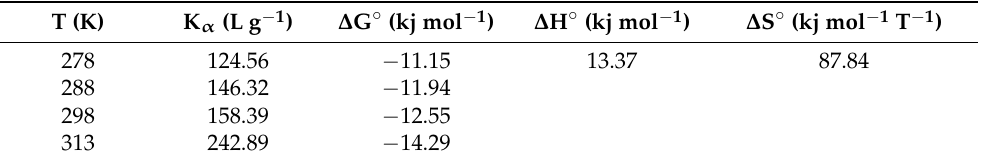
Figure 8. ( A ) Dependence of MB adsorption on temperature and ( B ) Vant’ Hoff plot of the MB adsorption onto Lipo- some@PDA microspheres. Table 4. Thermodynamic parameters of the adsorption of MB onto Liposome@PDA.